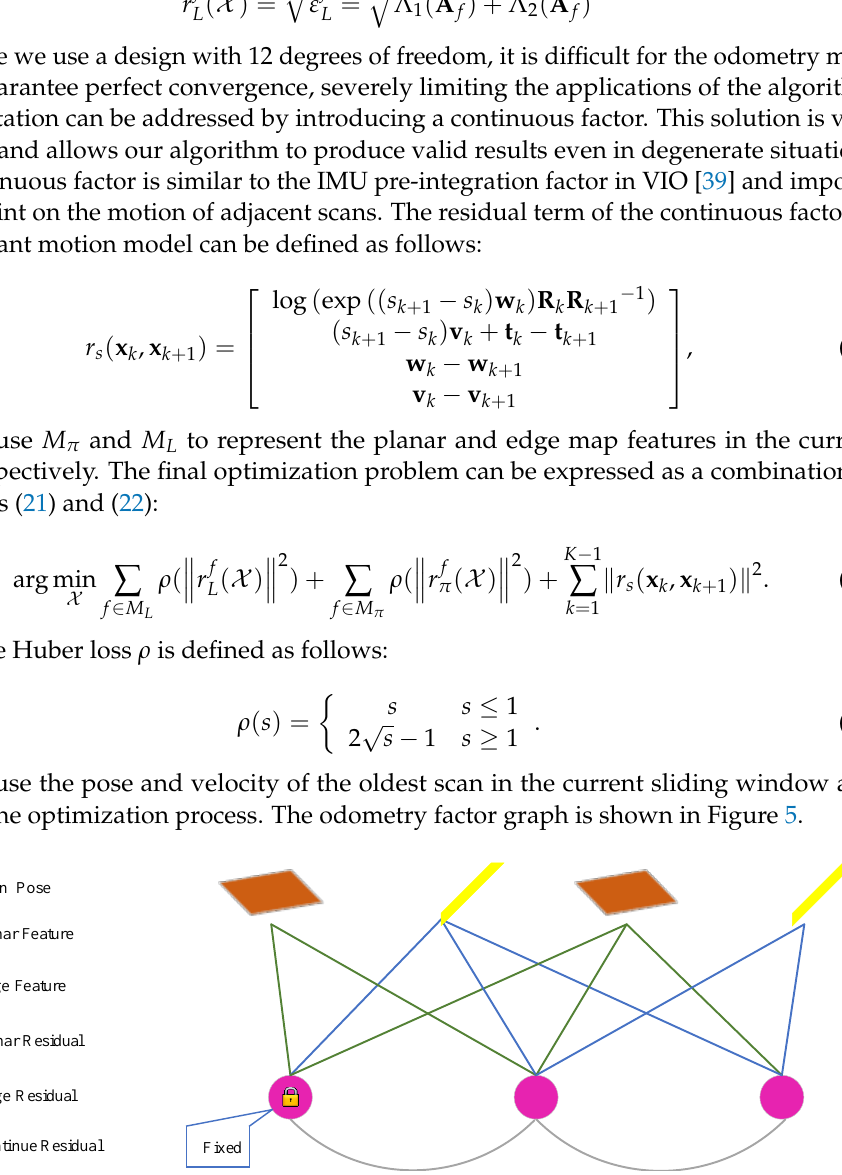
Figure 5. Illustration of our graph for odometry optimization. The first pose serves as a prior and is fixed during the optimization process. The planar and edge features impose constraints on all scans that observe them, while the constant motion model imposes constraints on neighboring